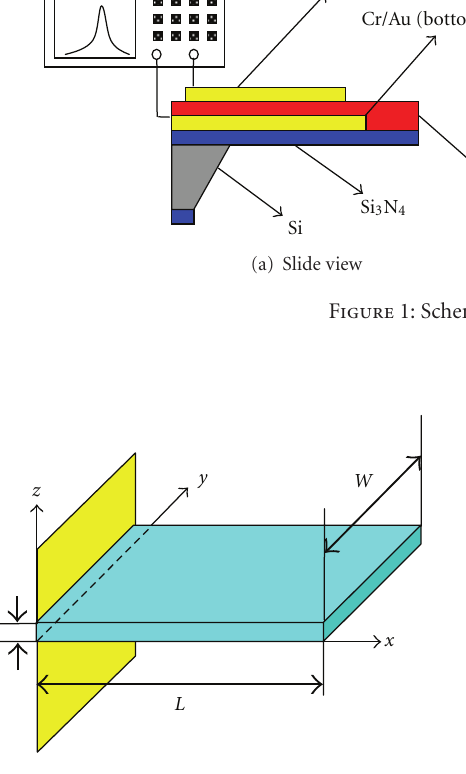
Figure 2: Schematic drawing of a rectangular cantilever.